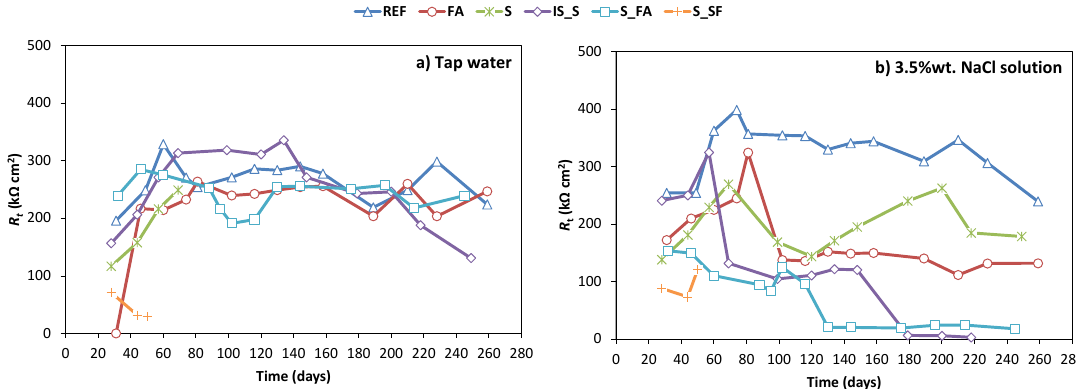
Figure 8. Total resistance of steel embedded in mortar immersed in ( a ) tap water and ( b ) NaCl 3.5 wt.% solution, with 7 days of curing prior to immersion or exposure.